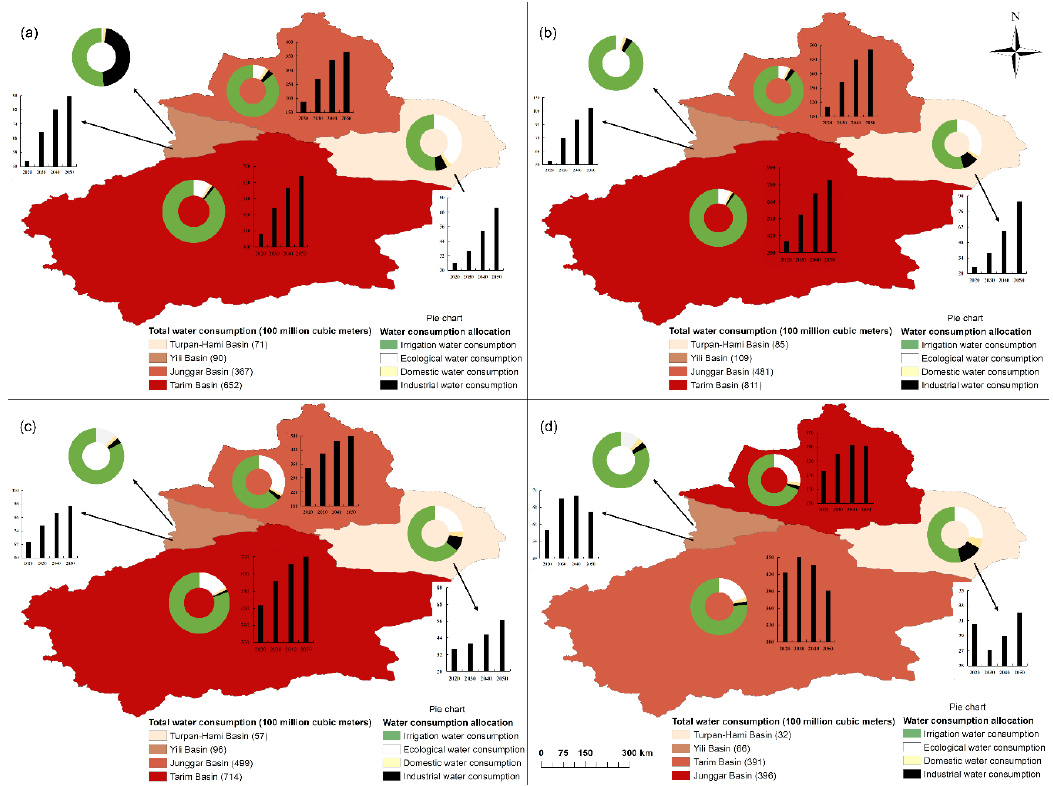
Figure 7. The future water consumption in sub-regions of Xinjiang under different scenarios. The pie charts represent the allocation of water consumption, and bar charts represent the changes in total water consumption. ( a – d ) are water consumption under scenario 1, scenario 2, scenario 3, and scenario 4, respectively.